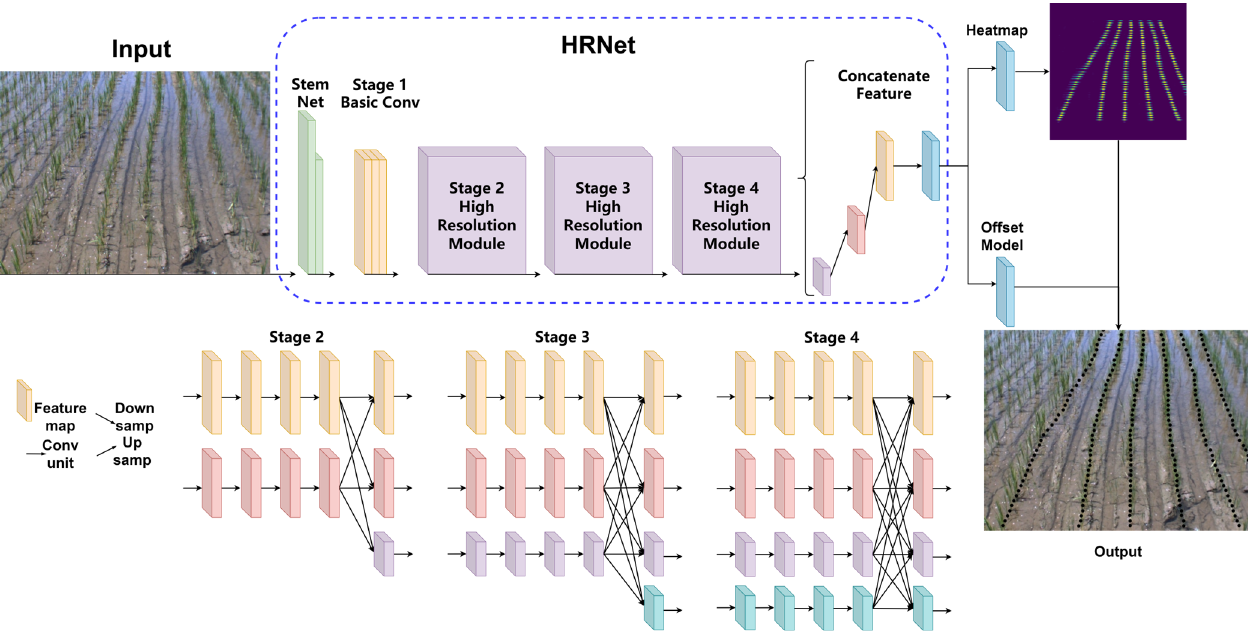
Figure 6. Network Architecture.